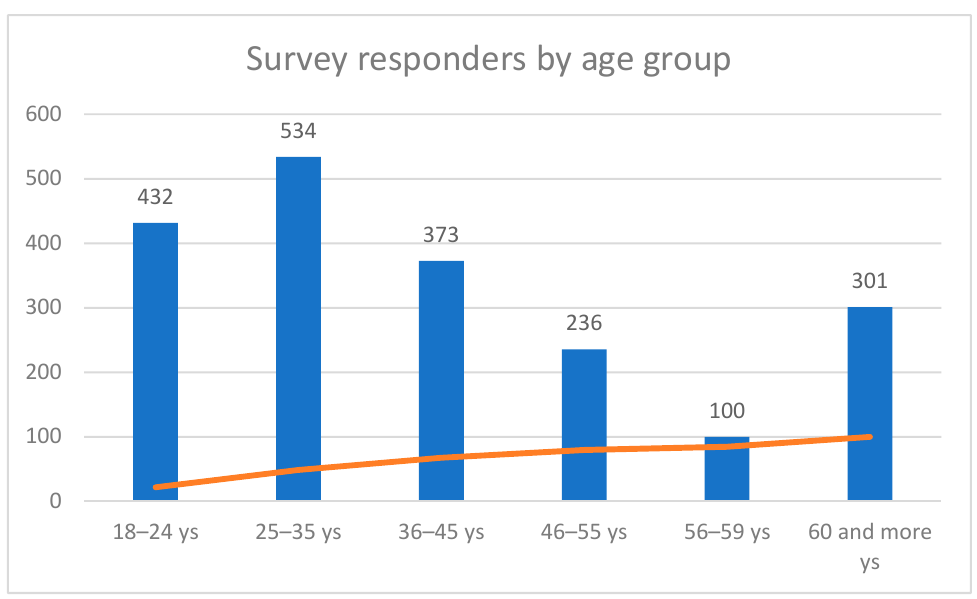
Figure 1. Quantity of the individual age groups in the examined population.